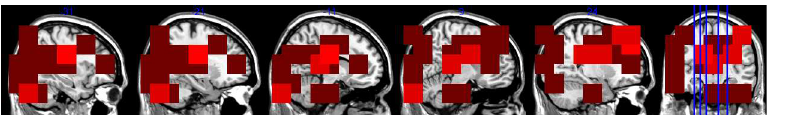
Fig 9. Extractedblock regions from ADHD-200 structural MRI dataset. See text for details.